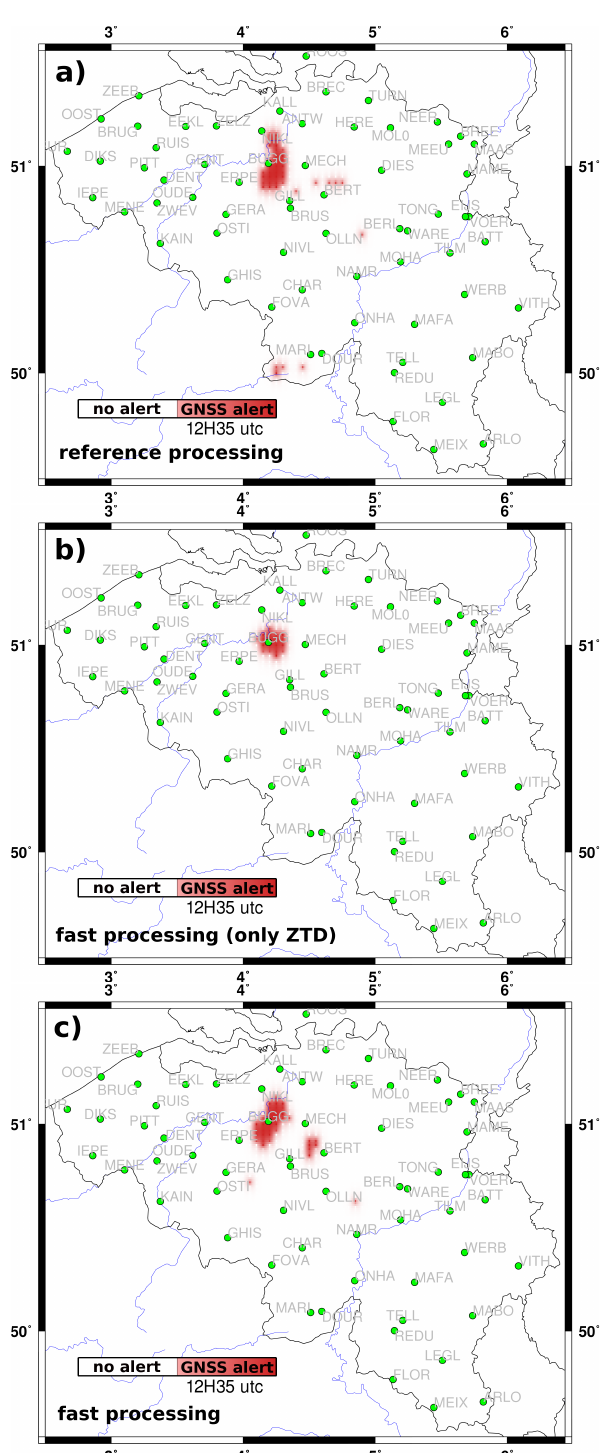
Figure 17. 2-D fields of GNSS H 2 O alerts (0 or 1) on 29 June 2005 at 12:35UTC: (a) from reference post-processing measurements (with ZTD and gradients), (b) from fast measurements (ZTD only), and (c) from fast measurements (with ZTD and